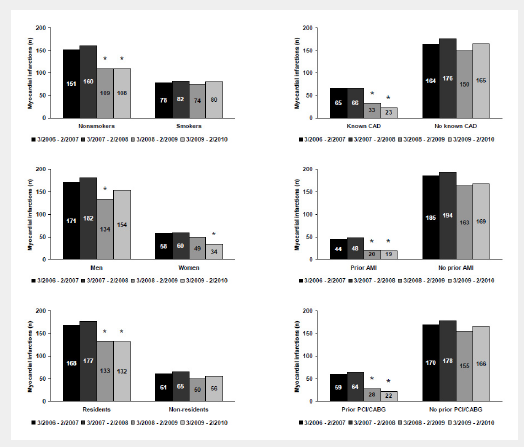
Numbers of myocardial infarctions in Graubünden (black bars) and Lucerne (grey bars) in the year(s) before and the years after implementation of a public smoking ban in Graubünden (dashed line). Note that no data were available for Lucerne for the first 12-month period because not all public hospitals in Lucerne participated in the AMIS Plus registry at that time. * P <0.05 vs. each of the 2 previous 12-month periods in Graubünden. † P <0.05 vs. the previous 12-month period in Lucerne. ‡ P <0.05 vs. each of the 2 previous 12-month periods in Lucerne.